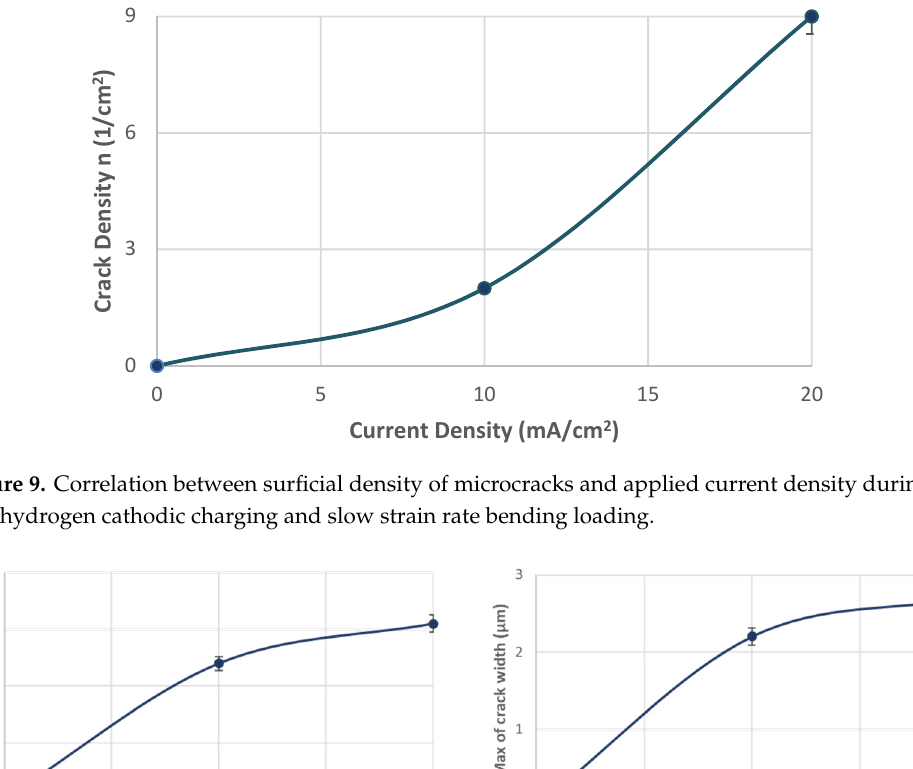
Figure 9. Correlation between surficial density of microcracks and applied current density during in situ hydrogen cathodic charging and slow strain rate bending loading.